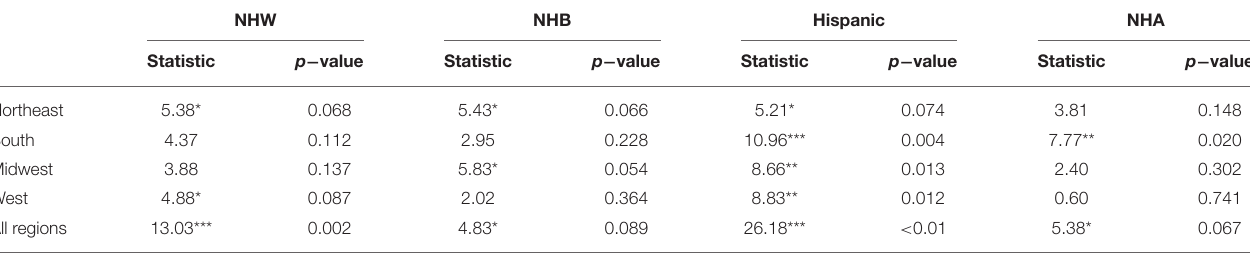
TABLE 1 | Non-parametric Kruskal-Wallis test for each ethnic group’s relative infection %, relative mortality %, and population percentages per region as groups and their significance levels.